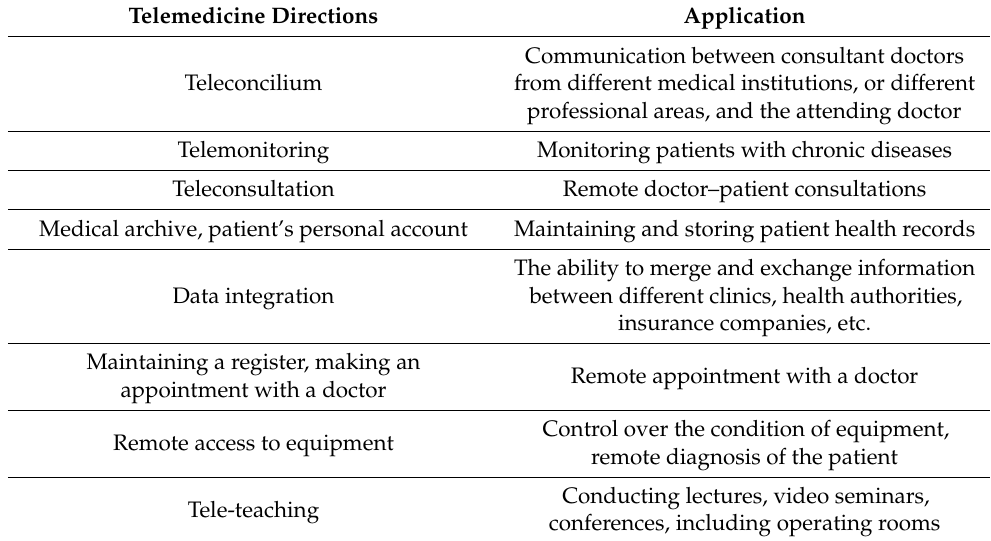
Table 3. Telemedicine